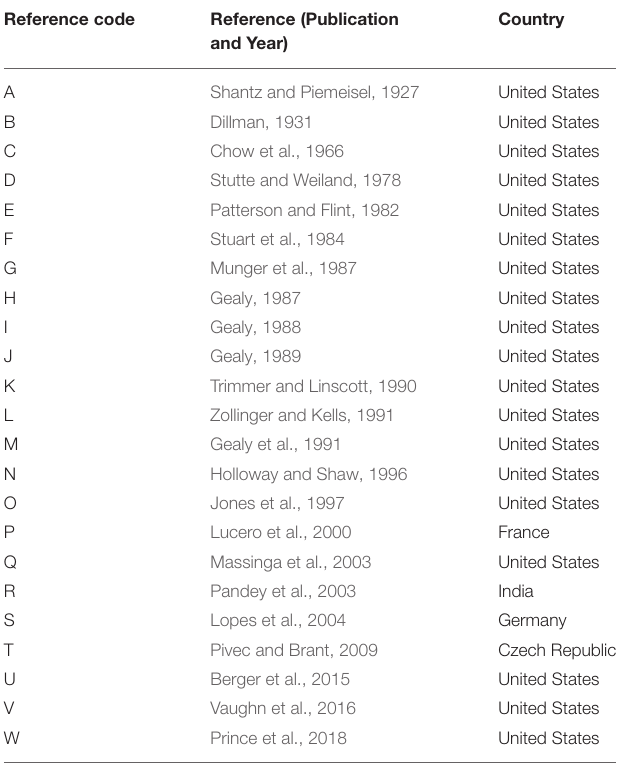
TABLE 1 | List of research studies selected and included in this systematic review ( n = 23 papers), with reference code, name and year of publication, and country of the research